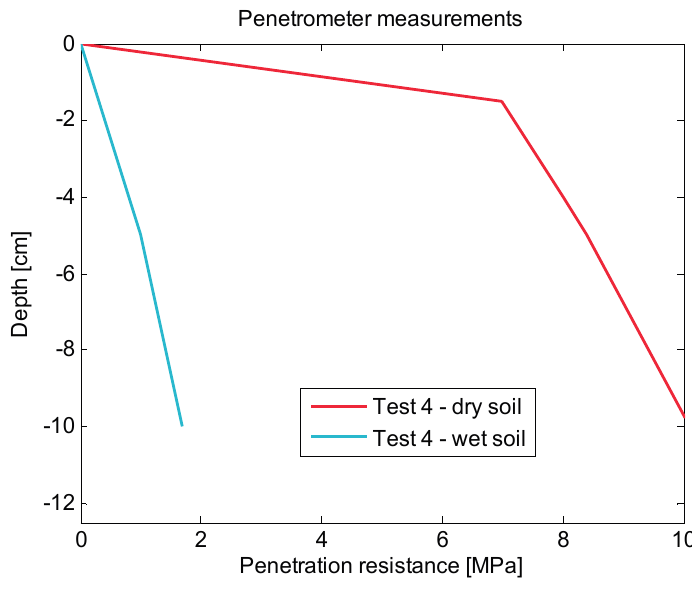
Figure 8. Soil penetration resistances acquired with the